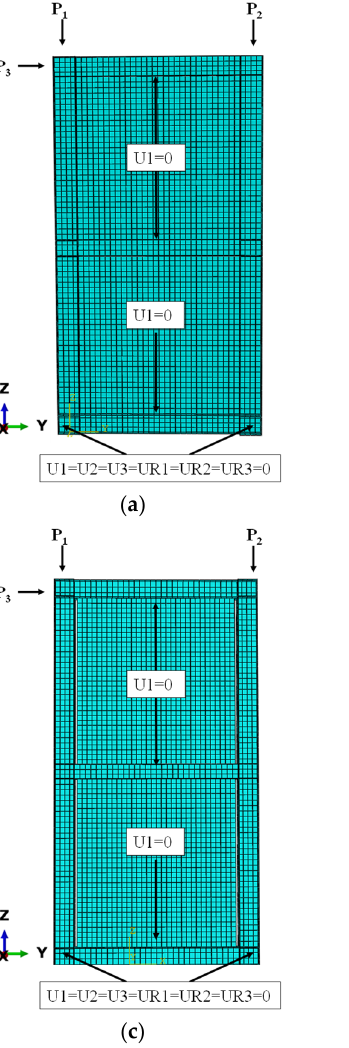
Figure 3. The boundary conditions of FEM models for SPSWs: ( a ) FSPSW; ( b ) OSPSW; ( c ) VSSPSW;